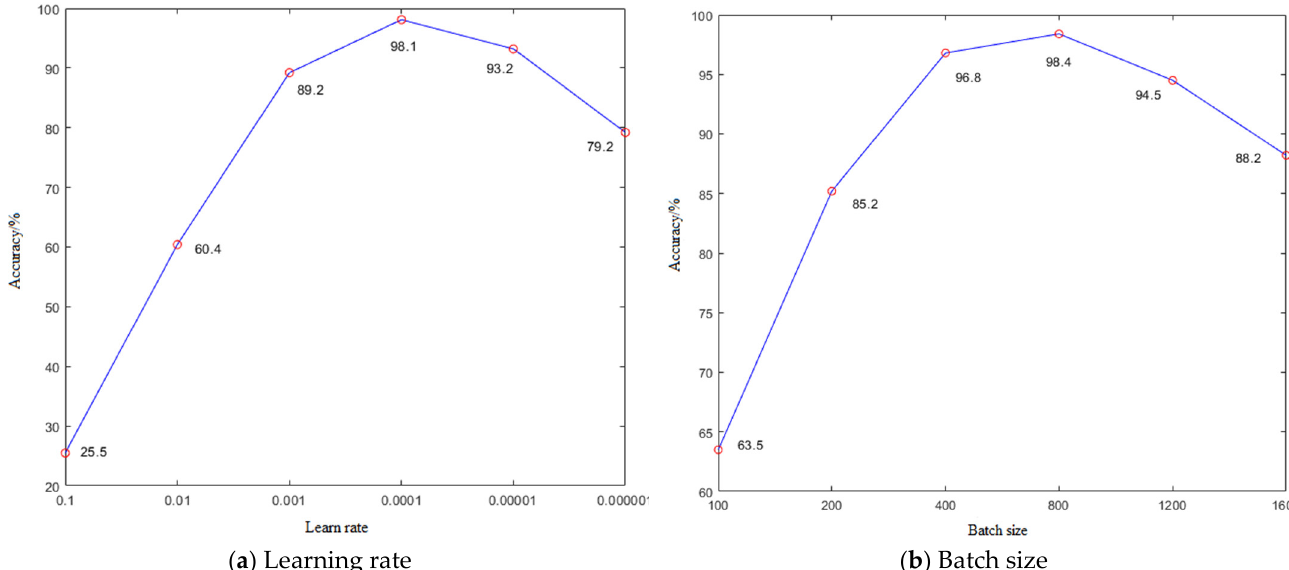
Figure 10. The effect of different parameters on the accuracy of fault diagnosis. Table 8. The simulation results of different learning rates and batch size. Table 8. The simulation results of different learning rates and batch size. Learning